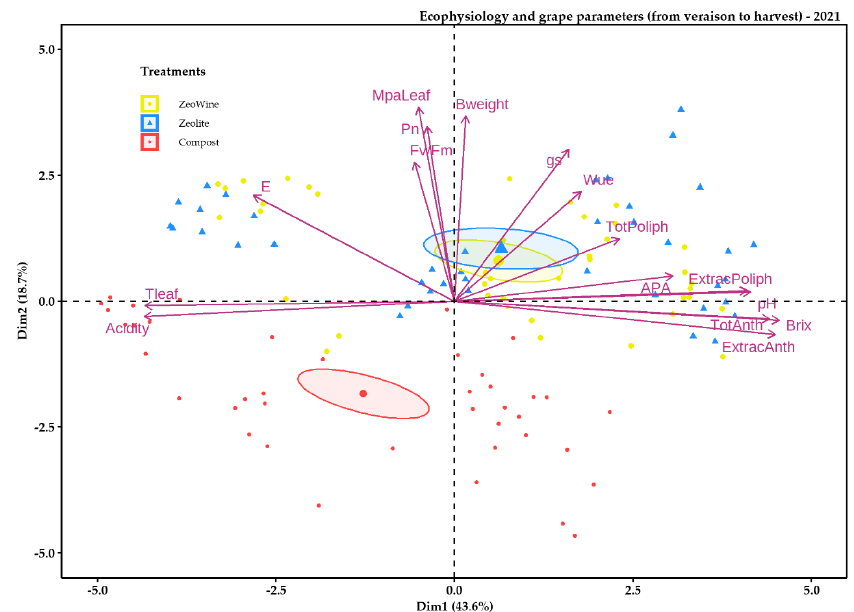
Figure 11. PCA ecophysiology and grape parameters 2021 season. PCA of the following variables (29 July, 18 August, 31 August, and 14 September): stem midday water potential, net photosynthe- sis, transpiration, leaf temperature, stomatal conductance, the fluorescence of chlorophyll, water use efficiency, sugar content, pH, acidity, total and extractable polyphenol, total and extractable anthocyanins, and YAN. potential (Dim1 43.6%). Instead, PC 2 (Dim2) explained 18.7% of the data variability.